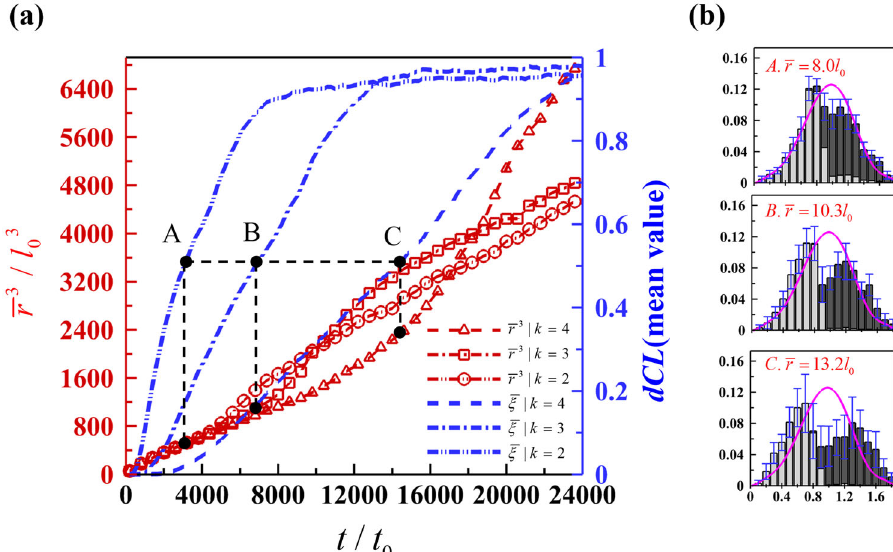
Fig. 8 Parametric study on the simulated growth kinetics of Al 3 Sc with spontaneous CL during Ostwald ripening. a Coef fi cient k = 2, k = 3, and k = 4, respectively. Points A/B/C correspond to mean dCL = 0.5 in the three cases. b Particle size distribution when the mean dCL = 0.5, corresponding to the points A/B/C. The meaning of the error bar and shades of bins is the same as in previous fi